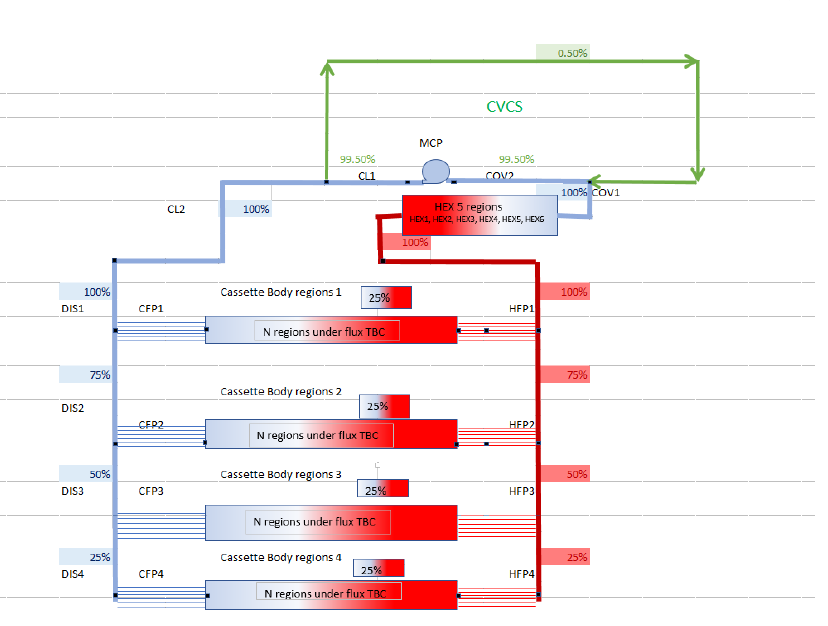
Figure 3. EU-DEMO Divertor cassette PHTS simplified scheme of the OSCAR-Fusion model. The 48 branches serving the tokamak cassettes have been simplified in 4 branches. The two loops of the PHTS have been condensed in one.